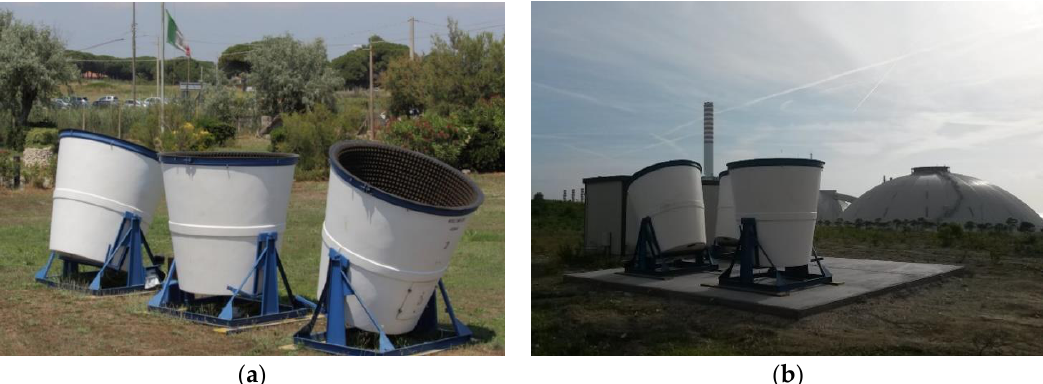
Figure 2. ( a ) The Doppler sodar antennas at the Saline of Tarquinia and ( b ) The Doppler sodar antennas near the ENEL Torrevaldaliga Nord thermal power plant at Civitavecchia.